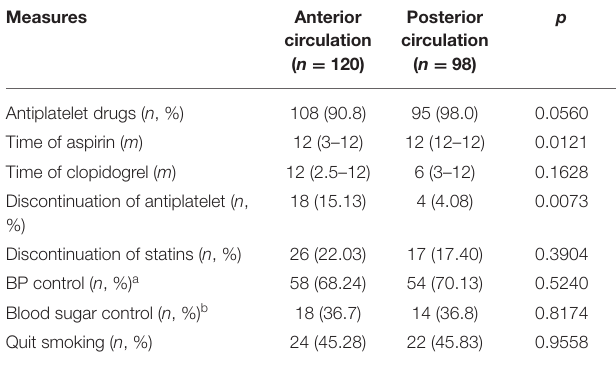
TABLE 1 | Baseline characteristics. TABLE 2 | Medication and lifestyle control at the 1-year follow-up.